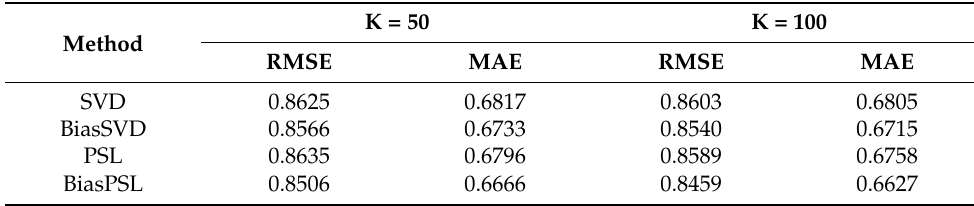
Table 3. The prediction result on MovieLen-1 M.